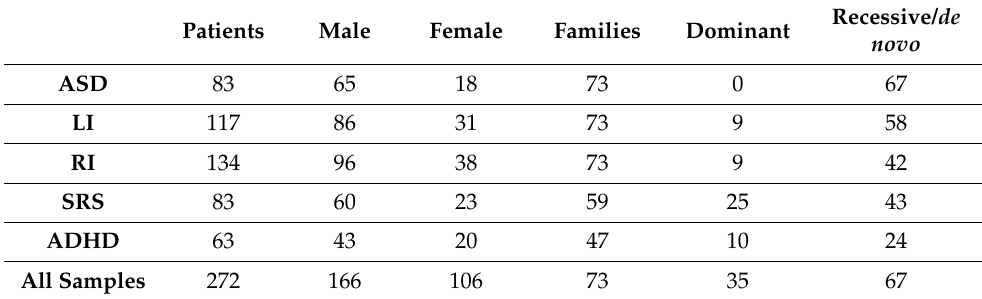
Table 1. Summary of Samples and